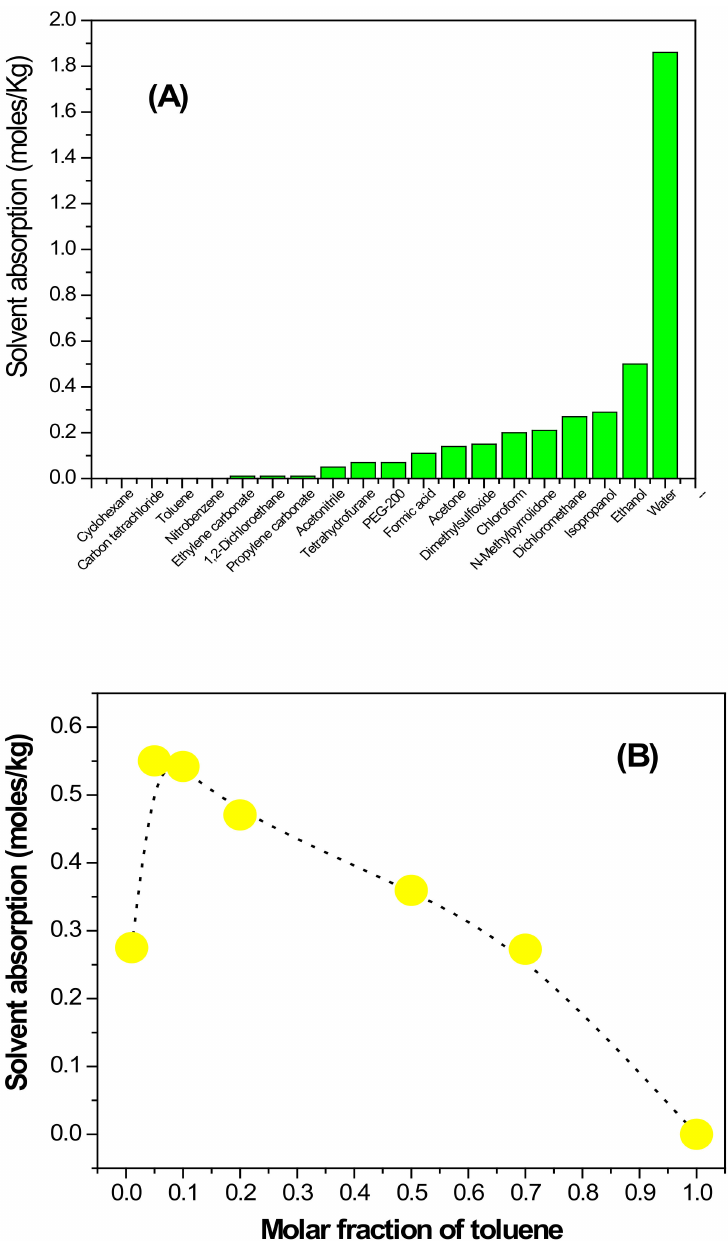
Figure 4. ( A ) Absorption (moles of solvent per kg of dry gel) of different solvents in PNIPAM. ( B ) Absorption (total moles of solvents per kg of dry gel) of a ternary mixture (water/ethanol/toluene) in PNIPAM gels. The composition of each ternary mixture is described in Table A1 (Appendix A). The dotted line is a guide to the